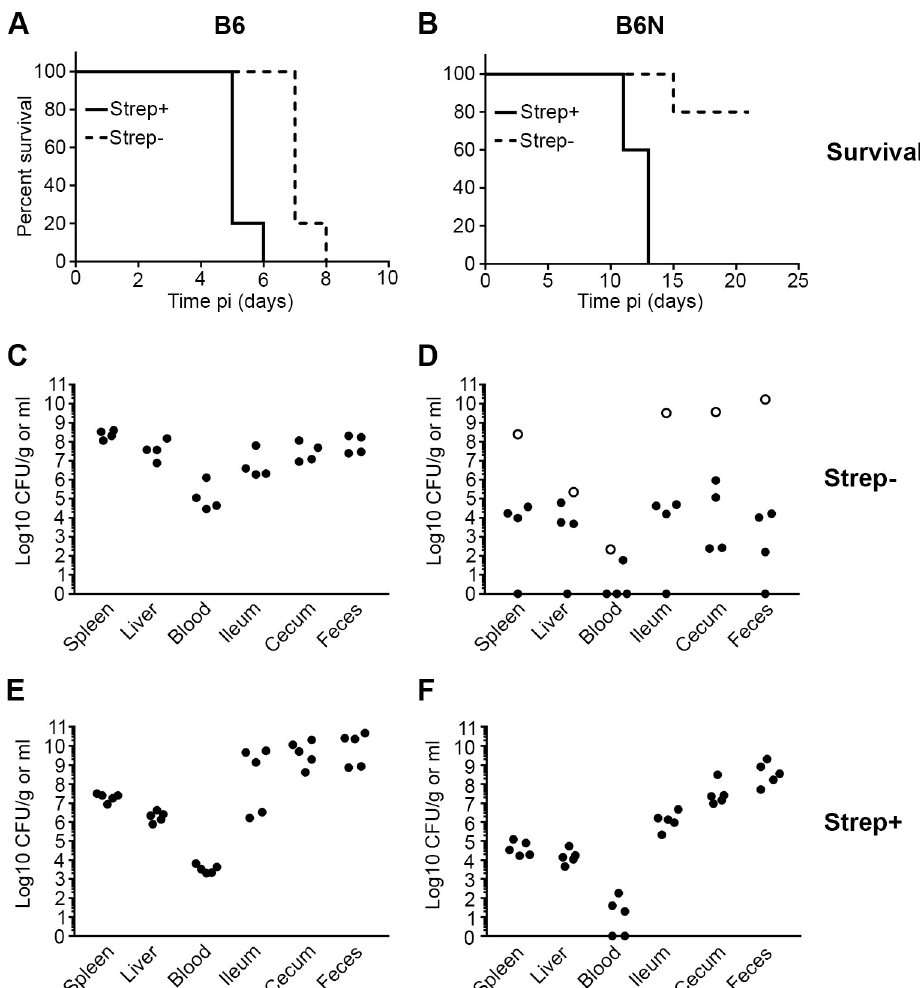
Fig 5. Kinetics of disease progression in mice inoculated by VC. Survival and bacterial loads of B6 (A, C, E) and B6N (B, D, F) mice. Strep- (not pretreated with antibiotic) and strep+ (pretreated with antibiotic in drinking water) mice were infected with 10 8 or 10 4 CFU respectively. n = 5 mice in each experiment and symbols represent individual mice. Open symbols in Fig 5D indicate the B6N mouse that was euthanized 15 days p.i. Tissues where bacterial load was below the level of detection are given a value of “1” for visualization